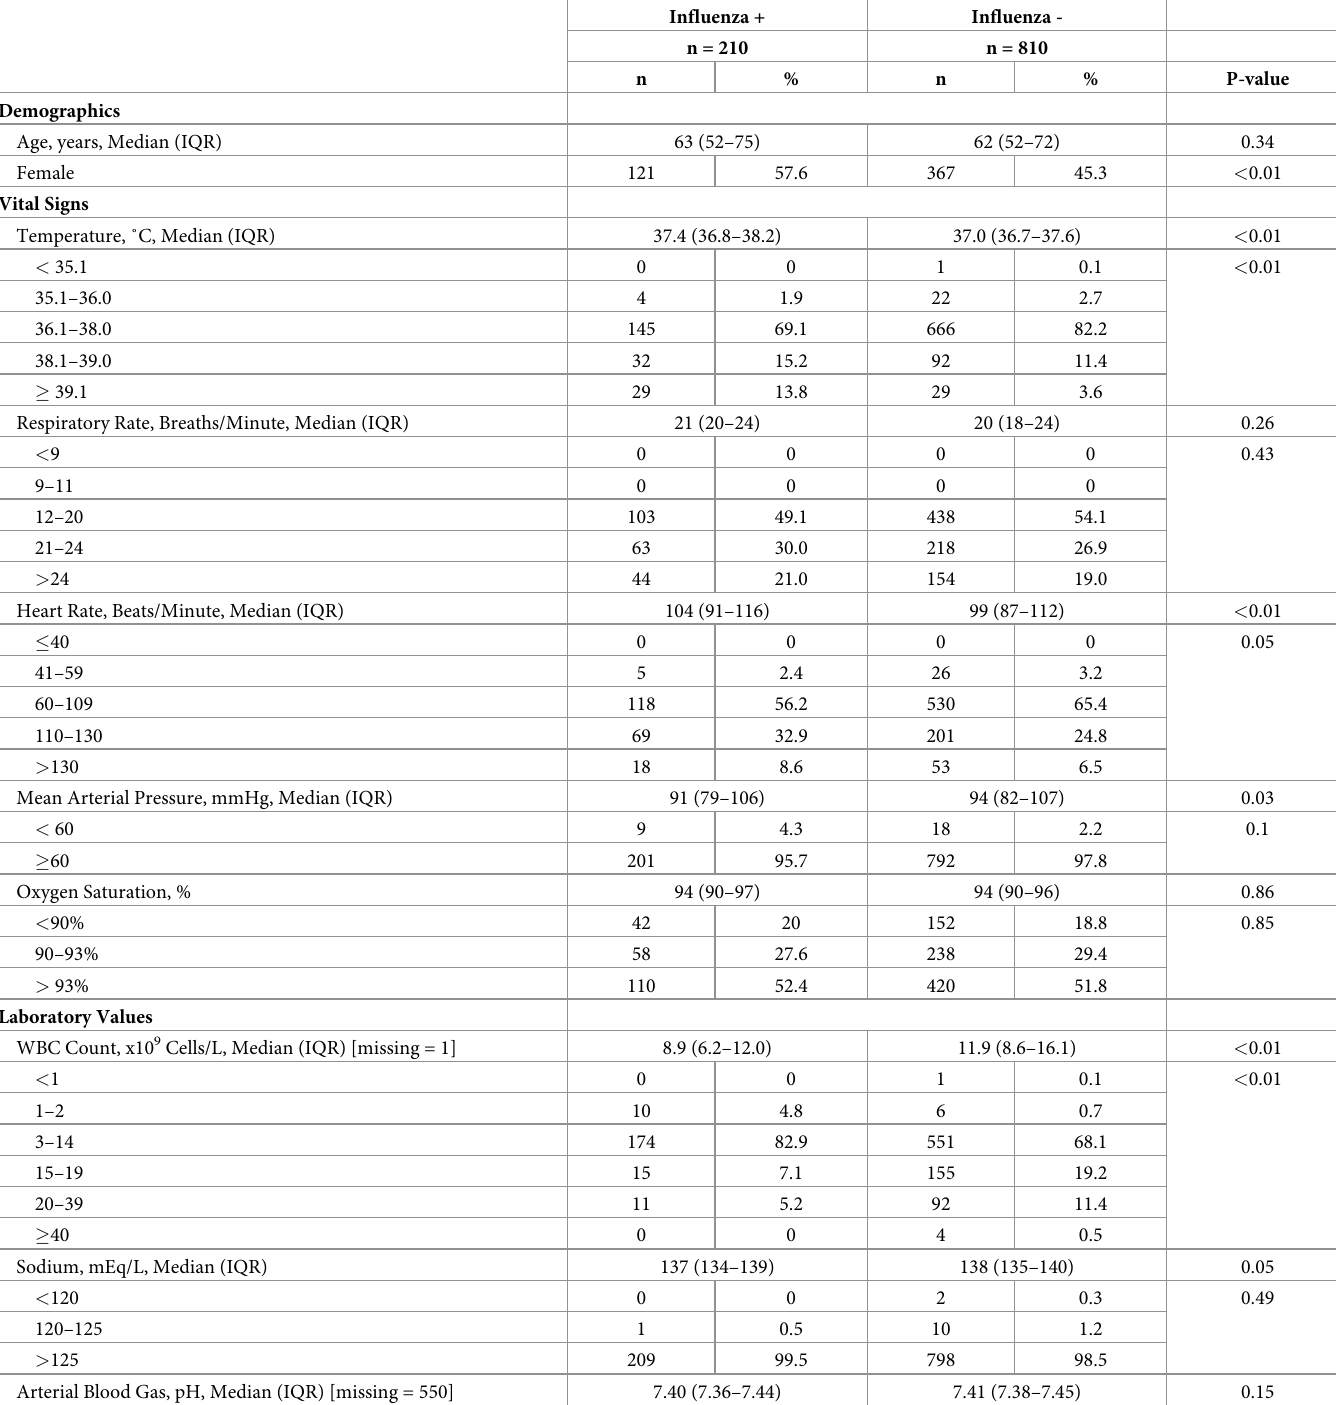
Table 3. Comparison of Physiologic Features and Interventions (PFI) 1 in hospitalized adults with lower respiratory tract infection, by influenza